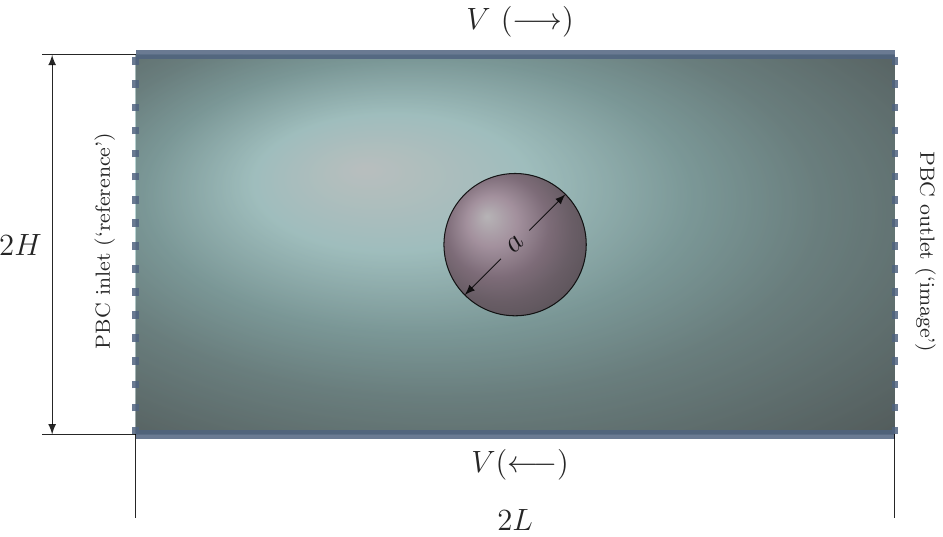
Figure 1. Schematic of the computational domain for a drop deforming in shear